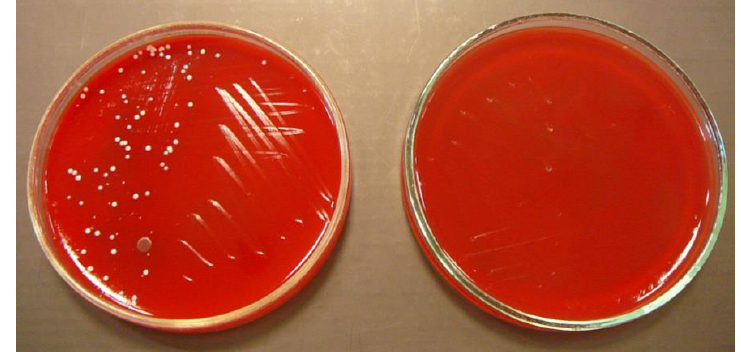
Figure 1. Blood agar with bacteria isolated from mobile phones before ( left ) and after ( right ) disinfection.